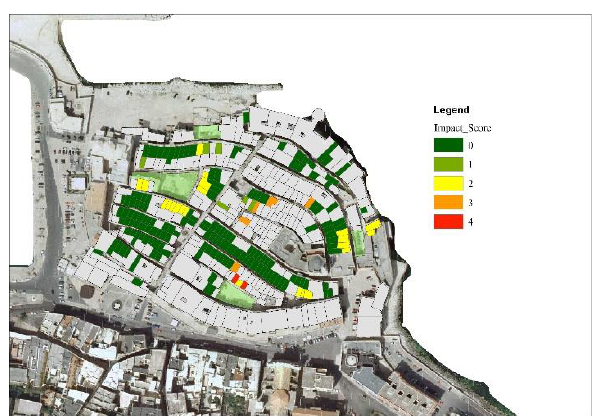
Figure 9 - Map of priority in energy impact evaluated for Building type